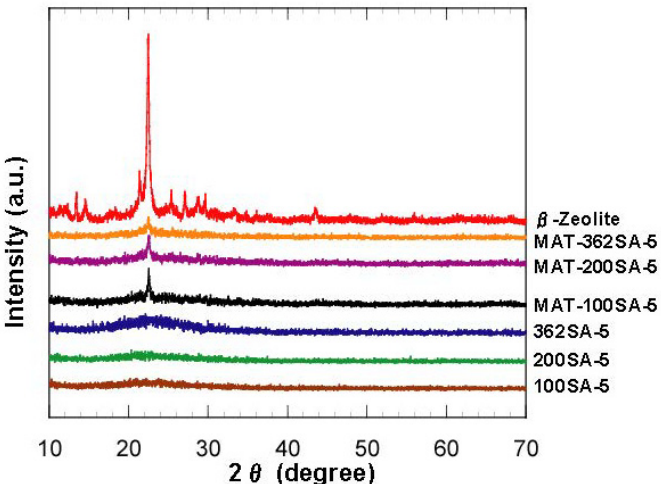
Figure 2. XRD patterns of zeolite, mixed catalysts and silica-aluminas.